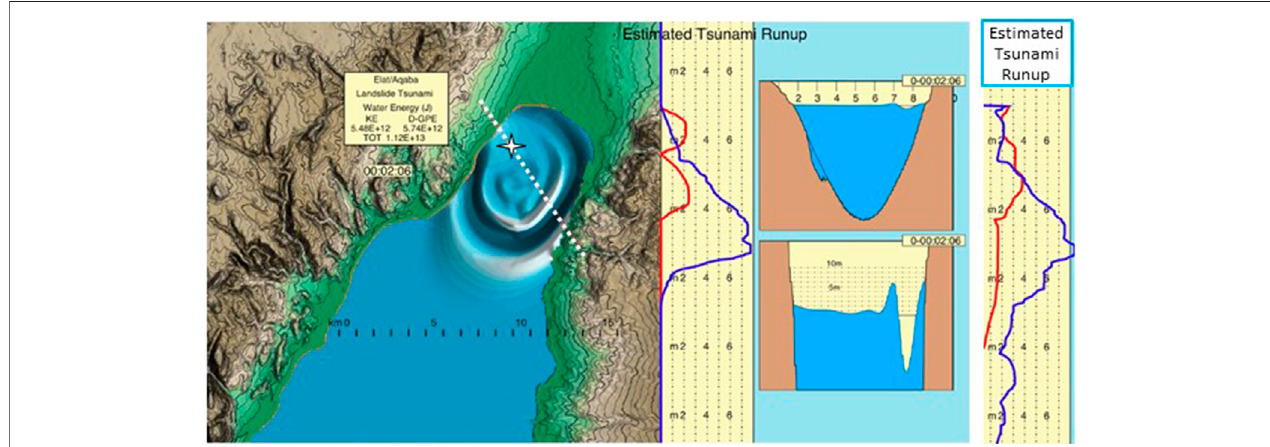
FIGURE 8 | Snapshot of the submarine-landslide tsunami at the head of the Gulf of Elat – Aqaba (HGEA) 2 min and 6 s after the start. The simulation followed the ‘ Tsunami Squares ’ approach (Wang et al., 2015). Maximal wave heights achieved until this moment along the western and eastern coasts are presented on the central diagram (red and blue lines, respectively). NW – SE cross sections (along the white dashed line on the map) on the right show the propagation of the waves. Note the locationofthelandslideonthemap(whitestar)andthescaronthebathymetryintheuppercrosssection.Thelowersectionzoomsinontheverticaldimensionand shows the shape and height of the advancing wave. Diagram on the right shows maximal wave heights achieved 10.5 min after the